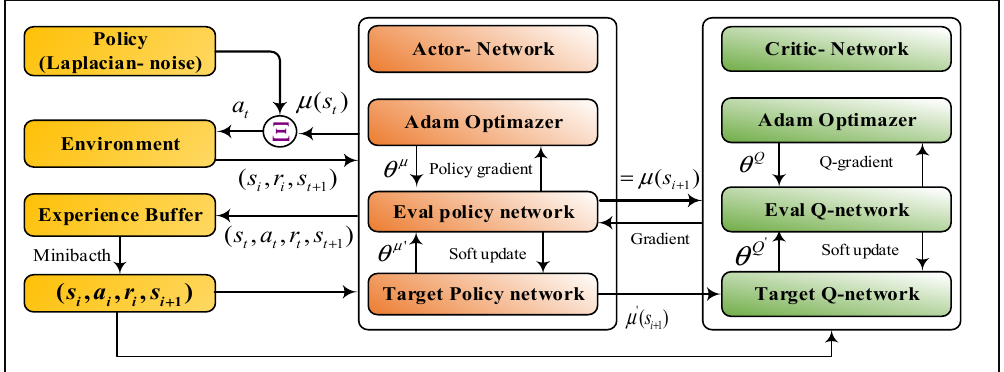
9 of 19 Algorithm 1: Framework of the DDPG for the WMR system. 1: Randomly initialize critic (cid:2283)((cid:1871),(cid:1853)|(cid:2016) (cid:3018) ) and actor (cid:2020)((cid:1871)|(cid:2016) (cid:3091) ) networks with weights (cid:2016) (cid:3018) and (cid:2016) (cid:3091) 2: Initialize target networks (cid:2283) (cid:4593) and (cid:2020) (cid:4593) with weights (cid:2016) (cid:2283) (cid:4594) ← (cid:2016) (cid:2283) , (cid:2016) (cid:3091) (cid:4594) ← (cid:2016) (cid:3091) 3: Set up empty replay buffer (cid:1844) 4: for episode = 1 to (cid:1839) do 5: